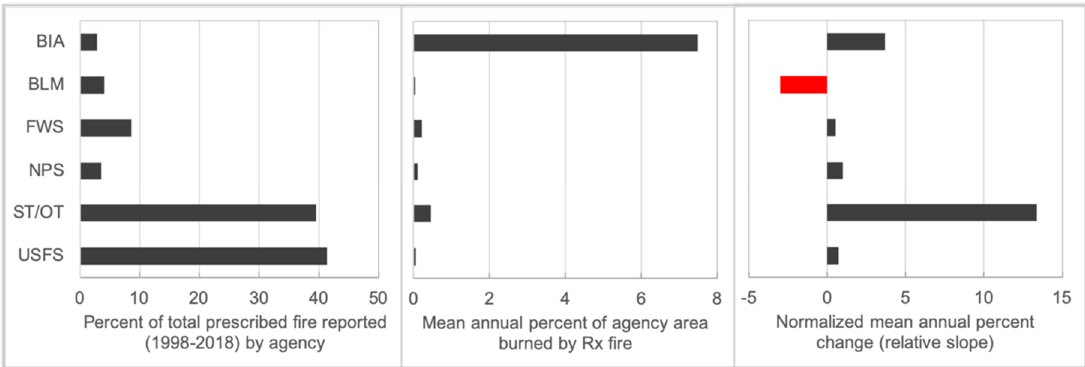
Figure 3. Percent of all reported prescribed fire nationally over the 21-year period (1998–2018) stratified by agency (left panel), mean annual percent of agency area burned by prescribed fire (i.e., area-normalized mean accomplished; center panel), and normalized (by mean annual total accomplishment per agency) mean annual change in prescribed fire completed (i.e., relative slope per agency; right panel).